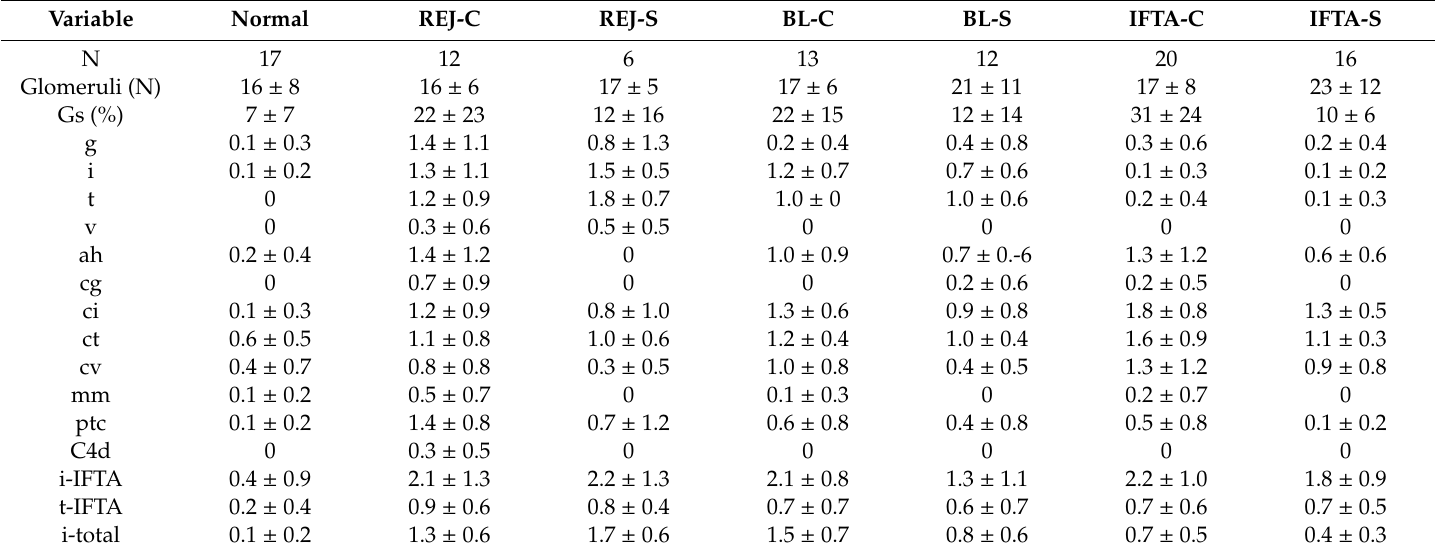
Table 3. Histological Ban ff